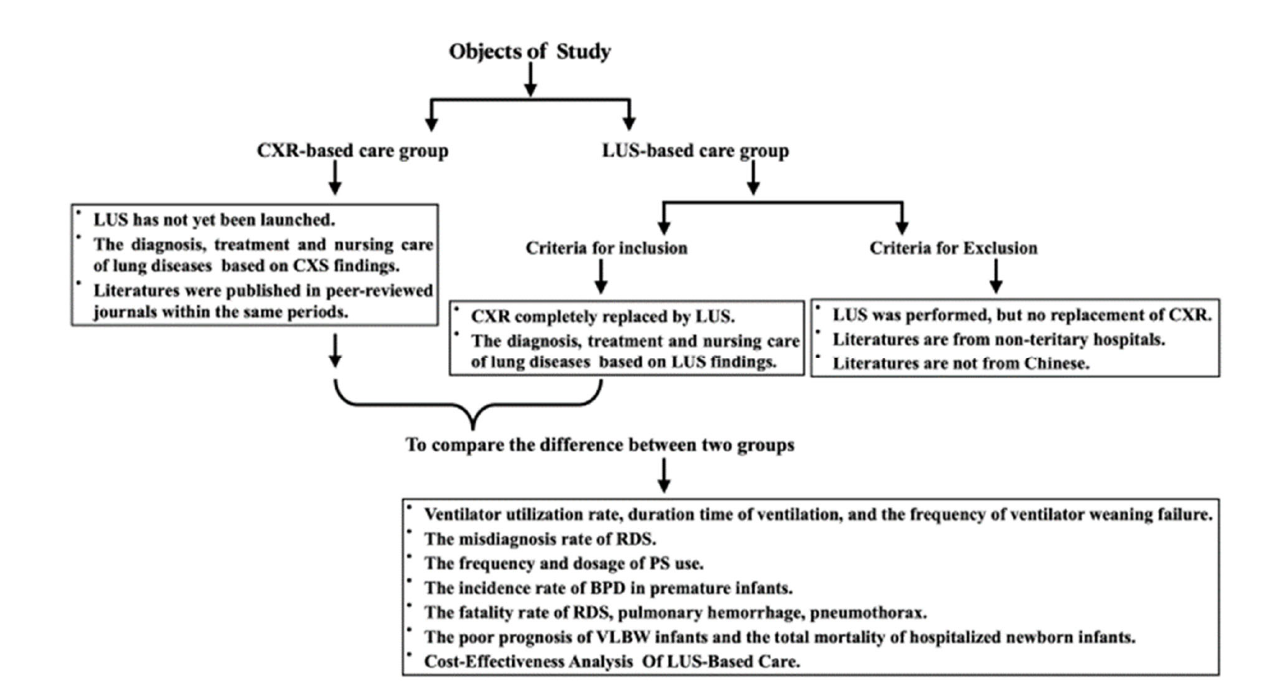
Figure 1. The flow chart of the data and cases selection methods.